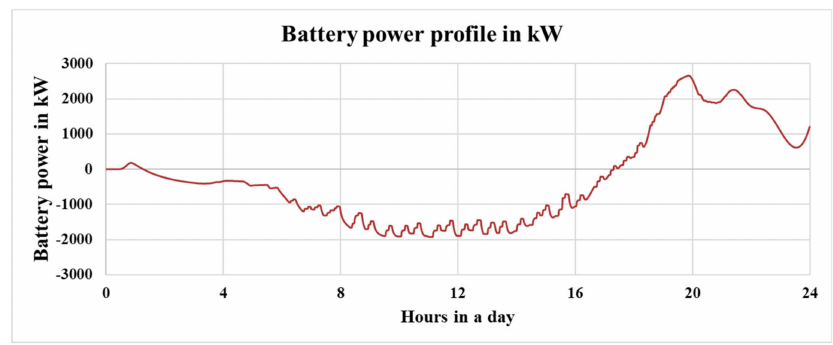
Figure 8. Power profile of supercapacitor in kW.